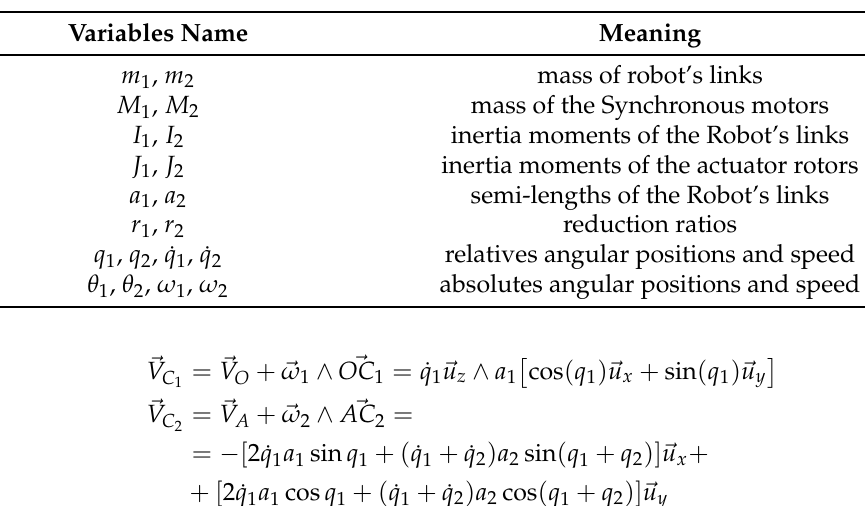
Table 1. Parameters of the dynamic Robot